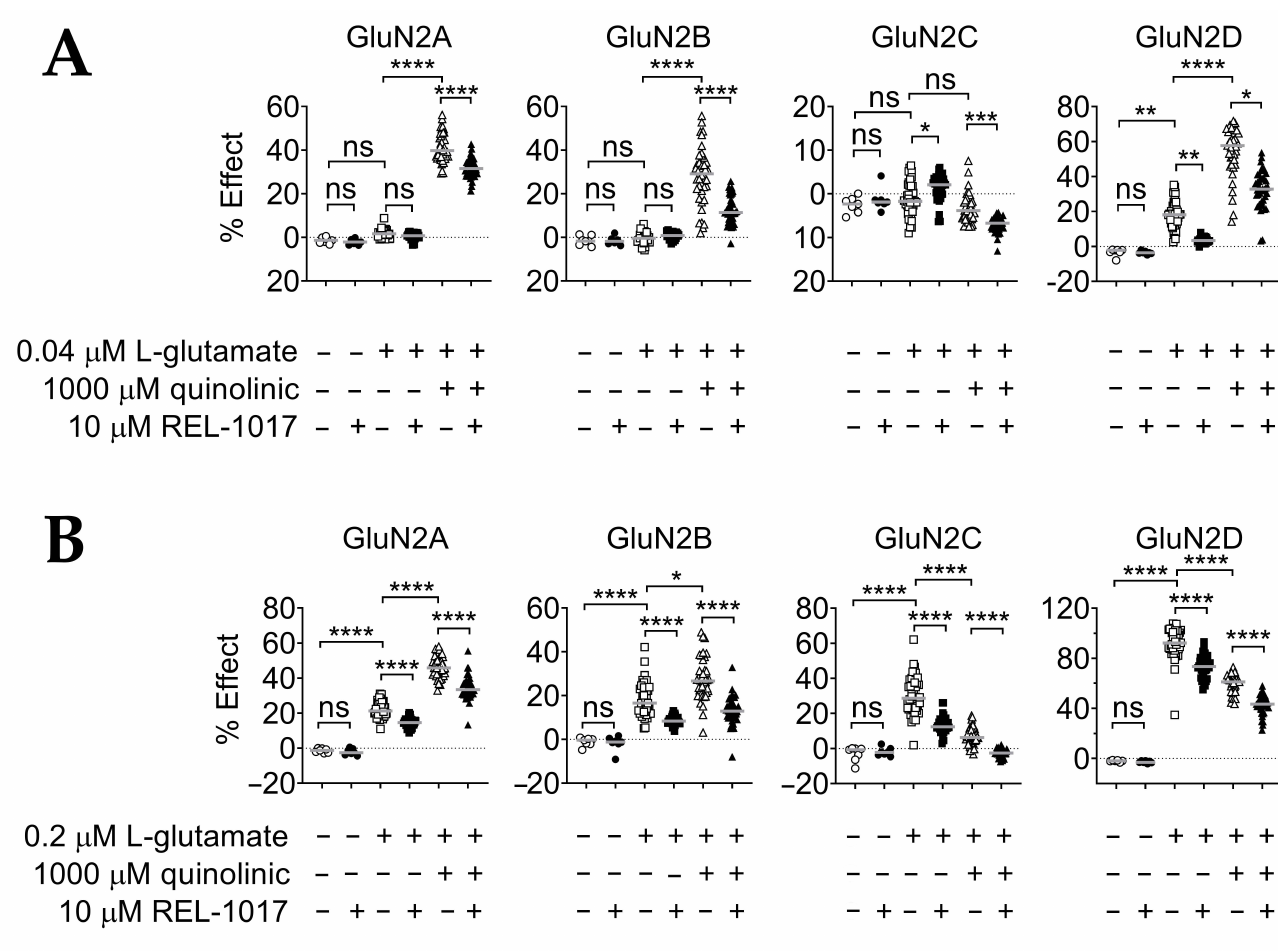
Figure 2. ( A ) Cell lines incubated with 10 µ M REL-1017 reduced calcium entry in the presence of 1000 µ M QA and 0.04 µ M L-glutamate. Then, 1000 µ M QA was tested in combination with 0.04 µ M L-glutamate; 0.04 µ M L-glutamate alone did not elicit [Ca 2+ ] in changes above an